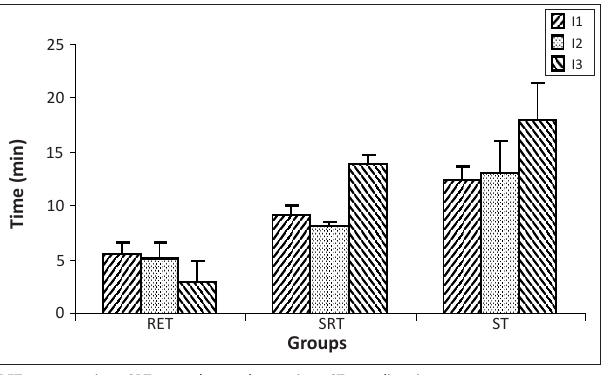
RET, recovery time; SRT, sternal recumbency time; ST, standing time. FIGURE 5: Mean ± standard error of recovery time, sternal recumbency time and standing time (min) in water buffaloes of different groups.